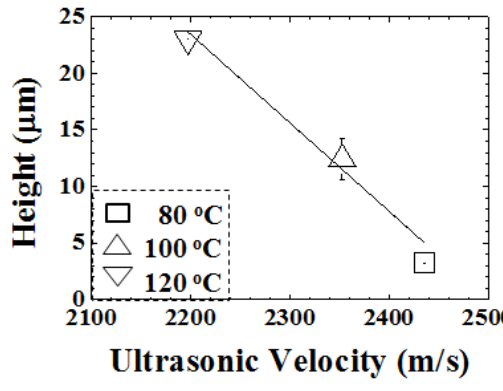
Figure 13. Height differences of the V-cut pattern under various temperature settings indicated by the ultrasonic velocity at the C status (cooling-start), with a ratio of −0.078 μm/(m/s). The ultrasonic velocity may be utilized to indicate the replication of the V-cut pattern under the various temperature